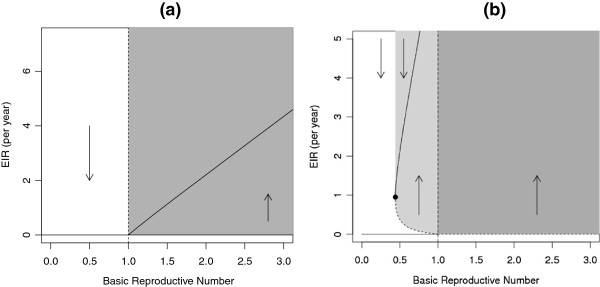
Bifurcation diagram for our model. Bifurcation diagram for malaria. The dashed line shows R0=1 and the arrows show the behavior of the system: in the white area, to the left of the manifold, the disease will die out while to the right of the manifold, in the shaded area, the disease will persist. The dark-shaded region represents the area in which malaria can invade and persist and the light-shaded area in which it persists, even though it would not invade. In these figures, all parameters are held constant except τN and τC. (a) A forward bifurcation occurs at R0=1. ρ=0.8. (b) A backwards bifurcation occurs at R0=1. ρ=4.